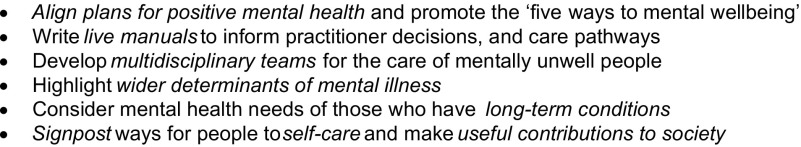
Examples of actions that primary care can undertake to improve mental health.